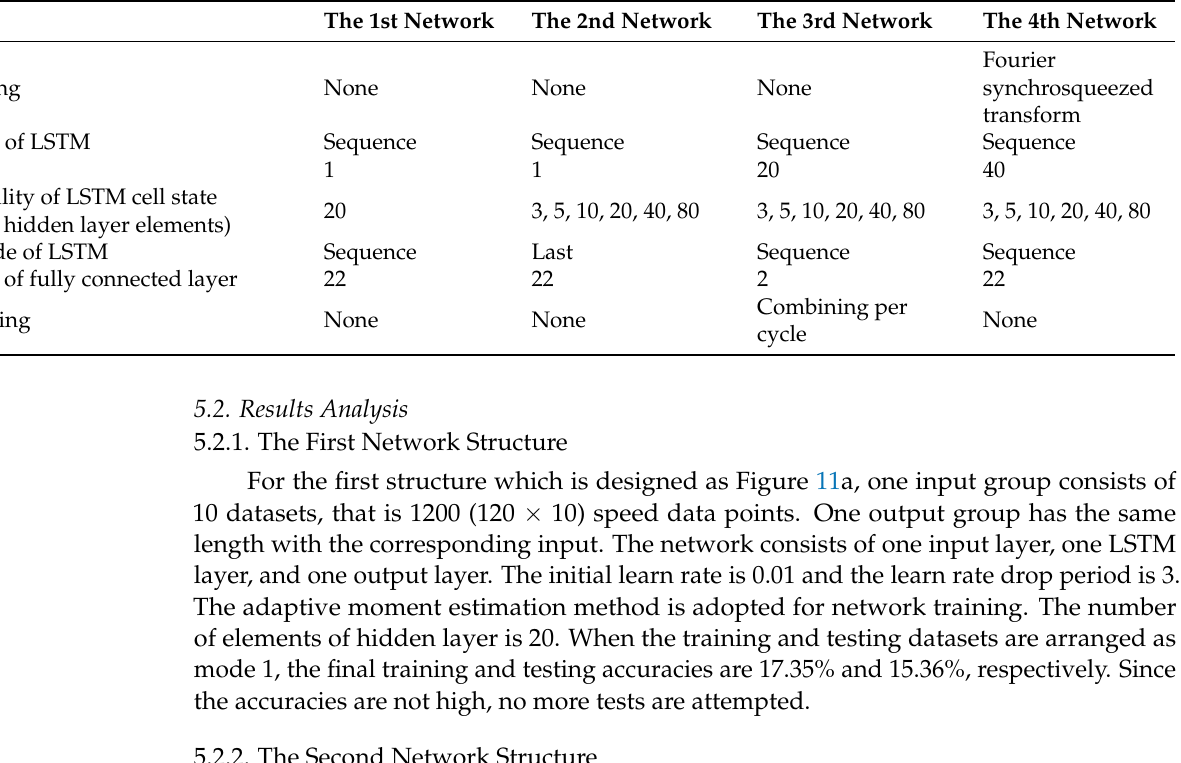
Table 4. The basic parameters of networks